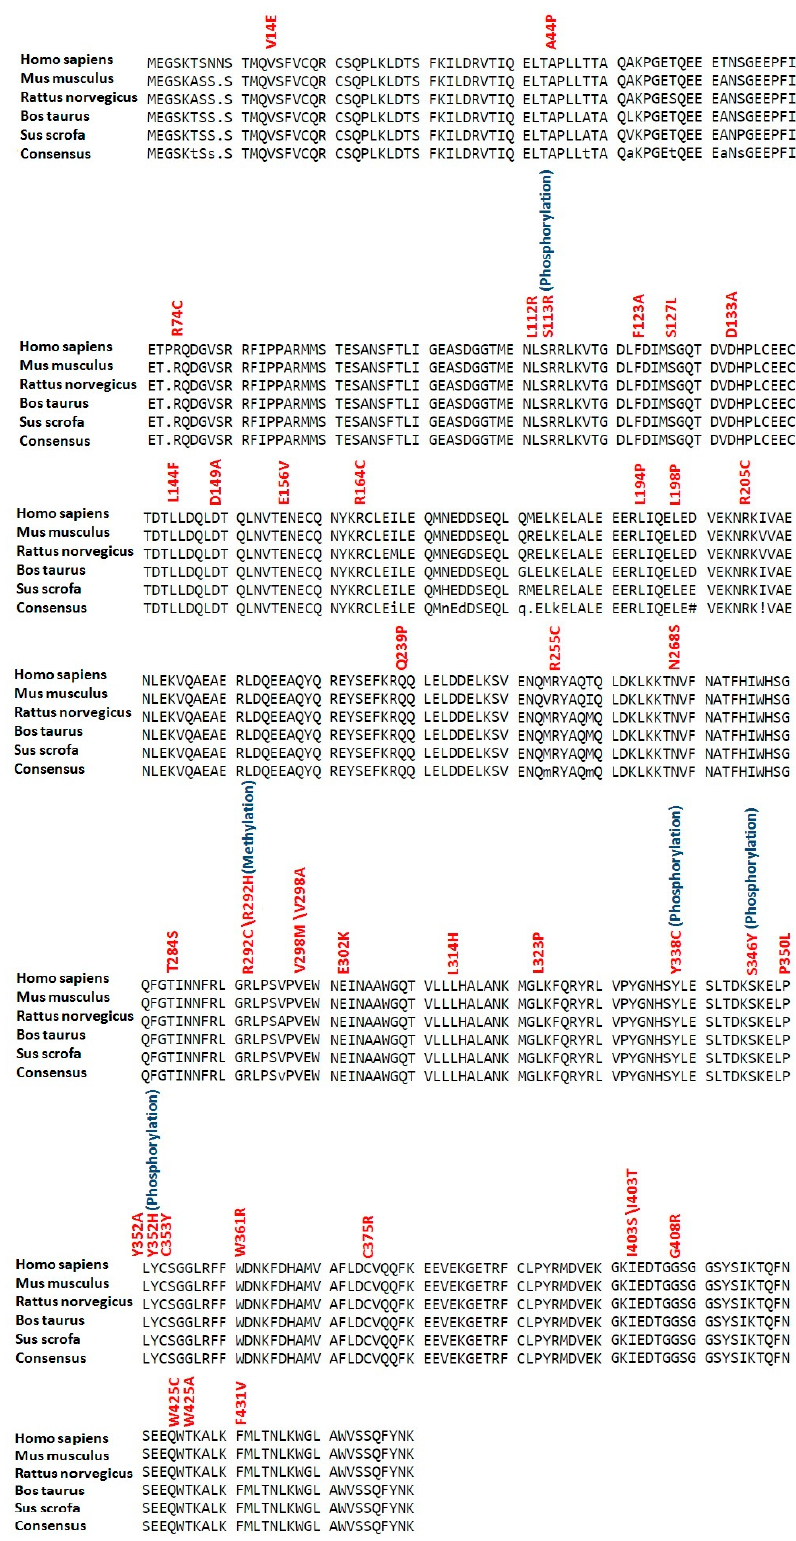
Figure 4. Conservation analysis of potential modified residues in BECN1 protein. Sequences of BECN1 proteins (human, mouse, rat, cattle and pig) were aligned using Multalin version 5.4.1 (http://multalin.toulouse.inra.fr/multalin/). High risk deleterious missense SNPs are mentioned in red color at respective positions while overlap with various types of posttranslational modifications are given in blue color.